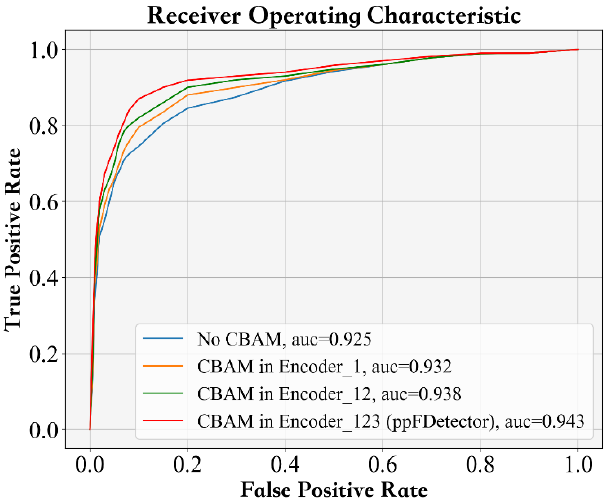
Figure 10. ROC curves of different CBAM embedding methods.